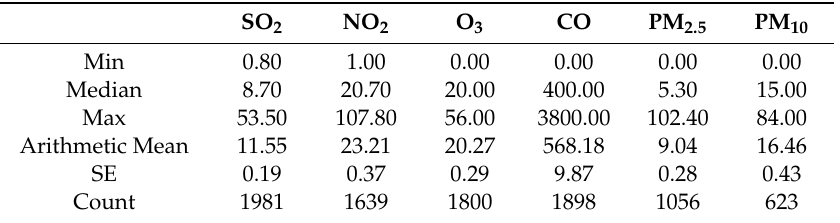
Table 1. Statistical summary of daily average concentrations of six criteria air pollutants ( µ g / m 3 for PM 2.5 and PM 10 , ppb for SO 2 , NO 2 , O 3 , and CO) in Fairbanks from November 2013 to May 2019. (SE: standard error) Measurements with negative observations are excluded. Maximums of PM 2.5 and PM 10 did not appear on the same day.